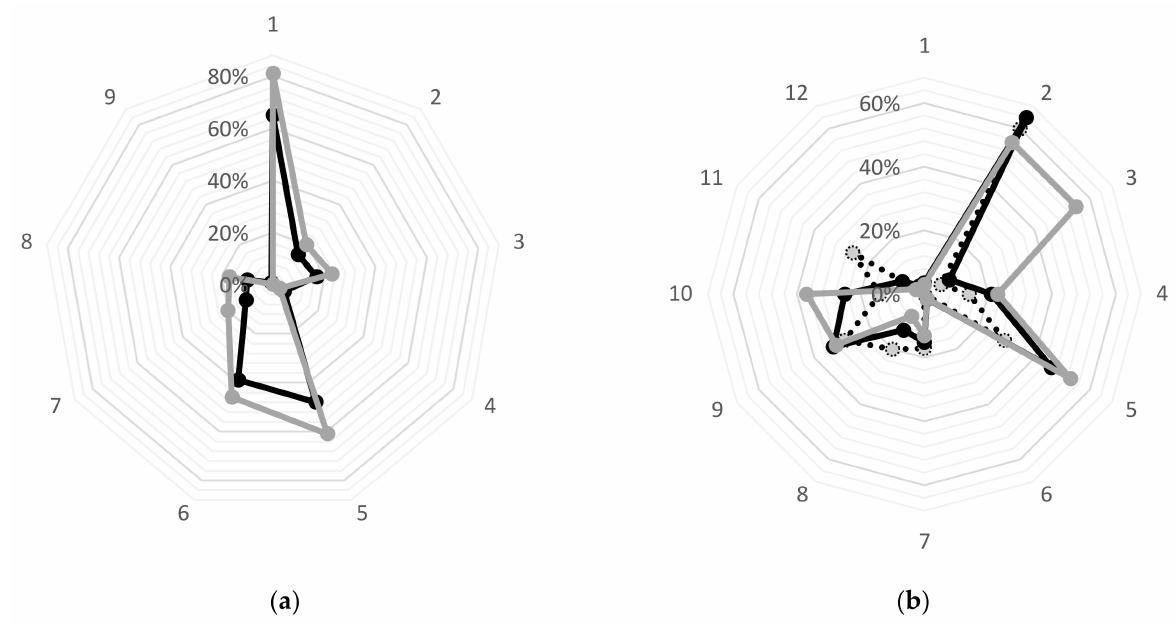
Figure 1. Reasons and barriers to consumption of organic food of respondents. ( a ) The reasons for consuming organic food (% of respondents) are as follows: (1) it is healthier, (2) it is tastier, (3) it contains more nutrients (vitamins, minerals, etc.), (4) it helps to treat diseases/allergies, (5) it does not contain artificial additives (preservatives, flavors, colors), (6) it is not genetically modified (without GMO), (7) out of concern for the environment, (8) I want to support organic farming and (9) it is a trendy food. ( b ) The barriers to consumption of organic food (% of female respondents) are as follows: (1) I do not know how to recognize organic food/I do not know how it is labelled, (2) organic food is too expensive/not worth the price, (3) not available/I have not seen it in shops, (4) organic food shops are too far away, (5) there is not enough choice of organic products in shops, (6) organic food is no different from conventional food, (7) I do not know the producers of organic food, (8) I do not trust certificates on products, (9) I prefer to buy products from a local farmer or market, (10) I prefer home-grown food, (11) I have no need for it/it does not matter to me and (12) I am disappointed with the quality/taste. Grey line = regular eco-con ( n = 290); black line= occasional eco-con ( n = 342); dashed line with grey bullet = non eco-con ( n =